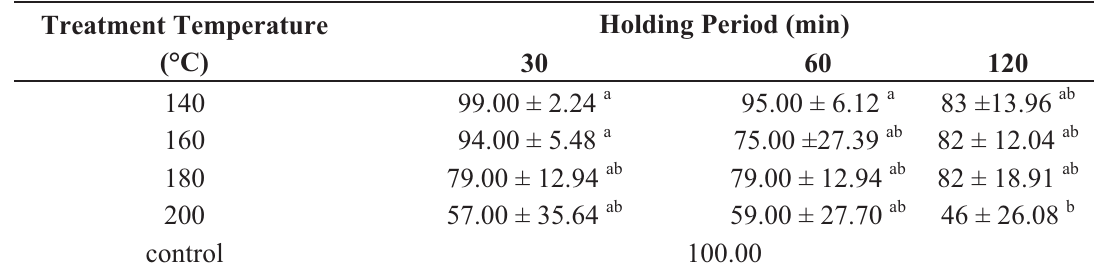
Table 2. Summary of damage rating after a 16-week exposure of D. asper to M. losbañosensis . Treatment